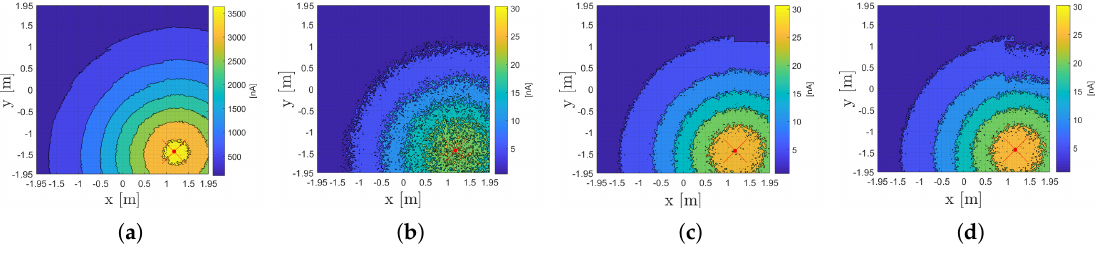
Figure 8. Distribution of I PD ,3 , which is measured in 157 2 grid points, for ( a ) VLP with AVG = 1 and SPECT fast Fourier transform (FFT)-based demodulation and for uVLP with AVG = 10 with, respectively, ( b ) SPECT-based, ( c ) PEAK-based and ( d ) correlation (C-FPh)-based